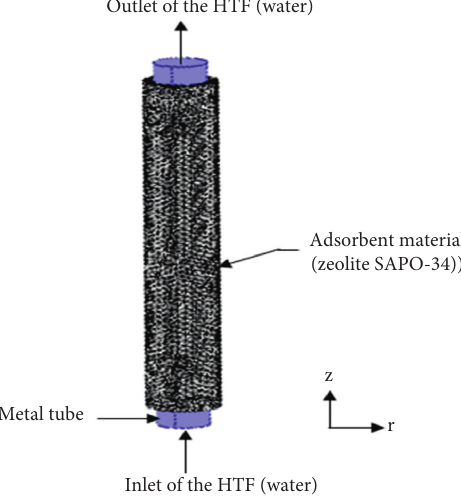
Figure 1: Schematic view of the cylindrical adsorbent